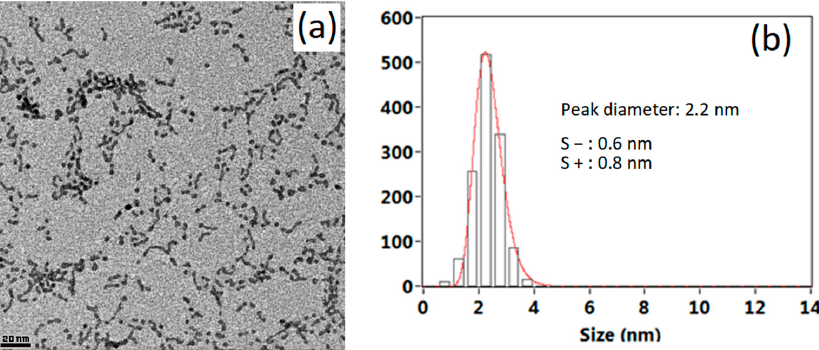
Figure 2. ( a ) Transmission electron microscopy (TEM) micrograph of the aqueous sample of palladium nitrate, after deposition on carbon-Cu grid, and ( b ) particle size distribution.